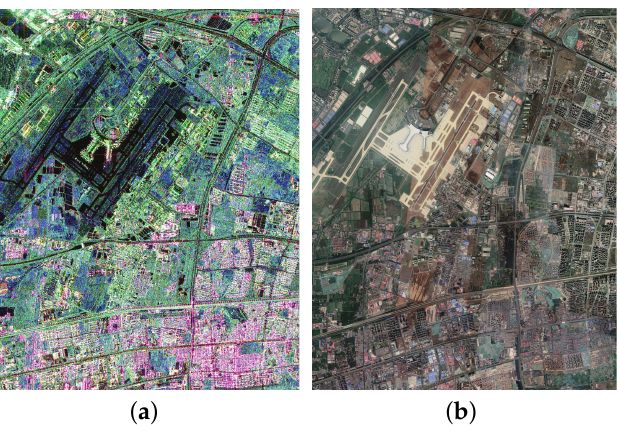
Figure 6. Tianjin Airport data. ( a ) PauliRGB image. ( b ) Google Earth